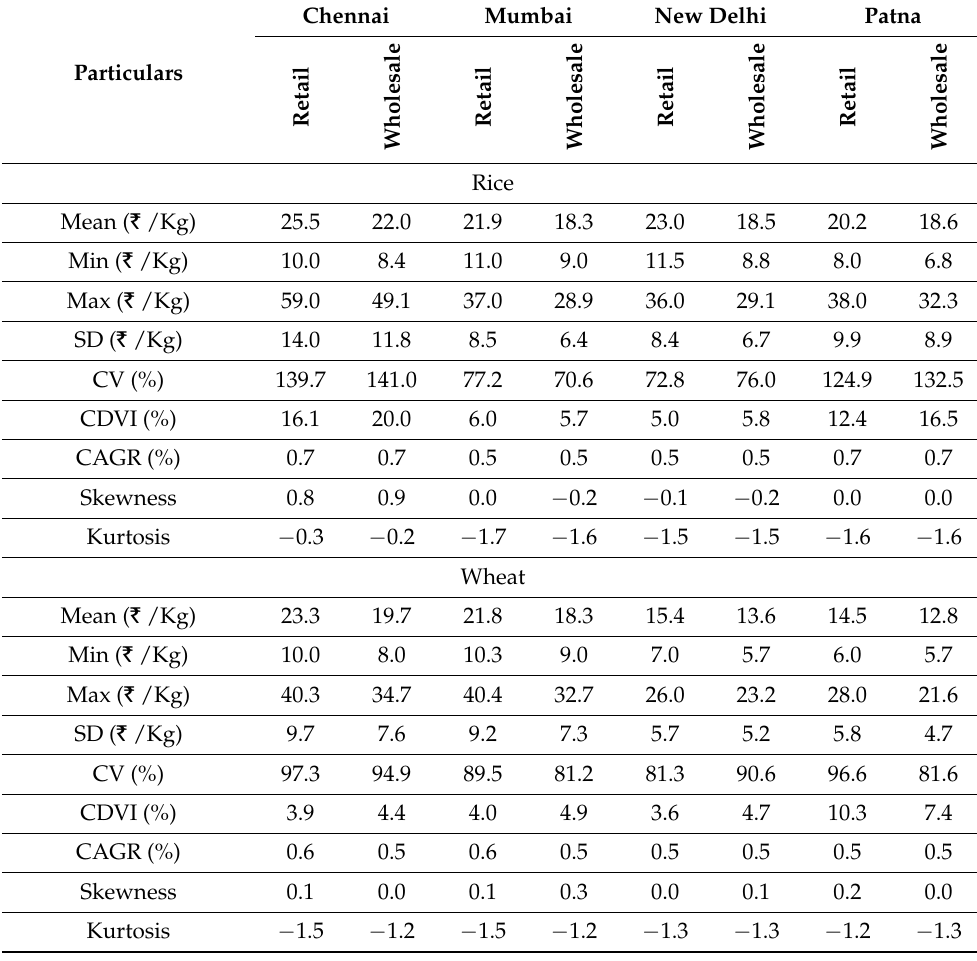
Figure 2. Price trends in selected wheat markets of India. Table 1. Summary statistics for the rice and wheat prices (July 2000 to June 2022). Particulars